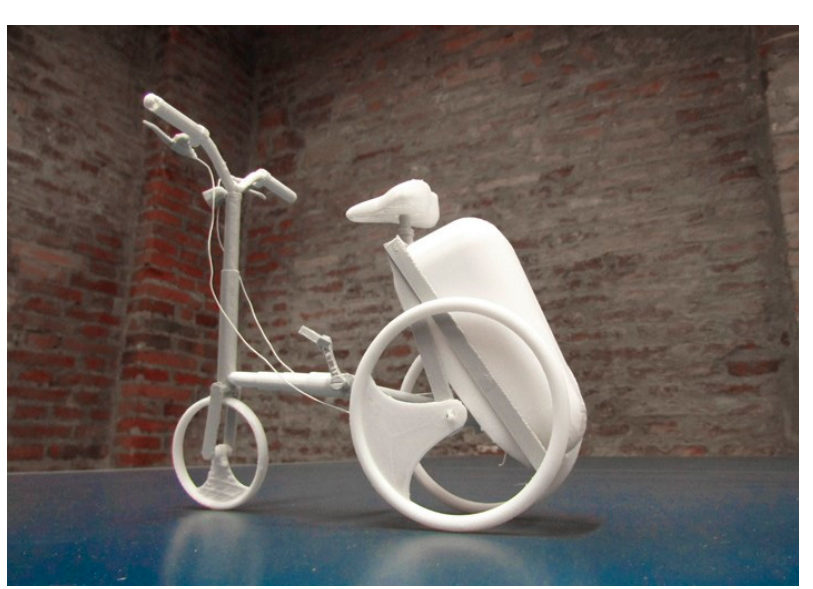
Figure 24. 3D printing bike.